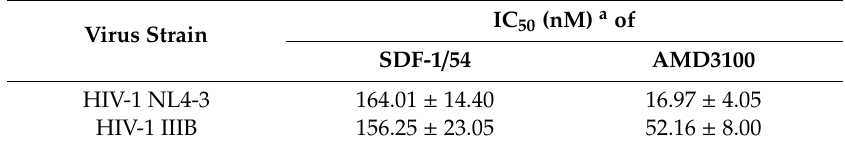
a The measurements were from three independent experiments.